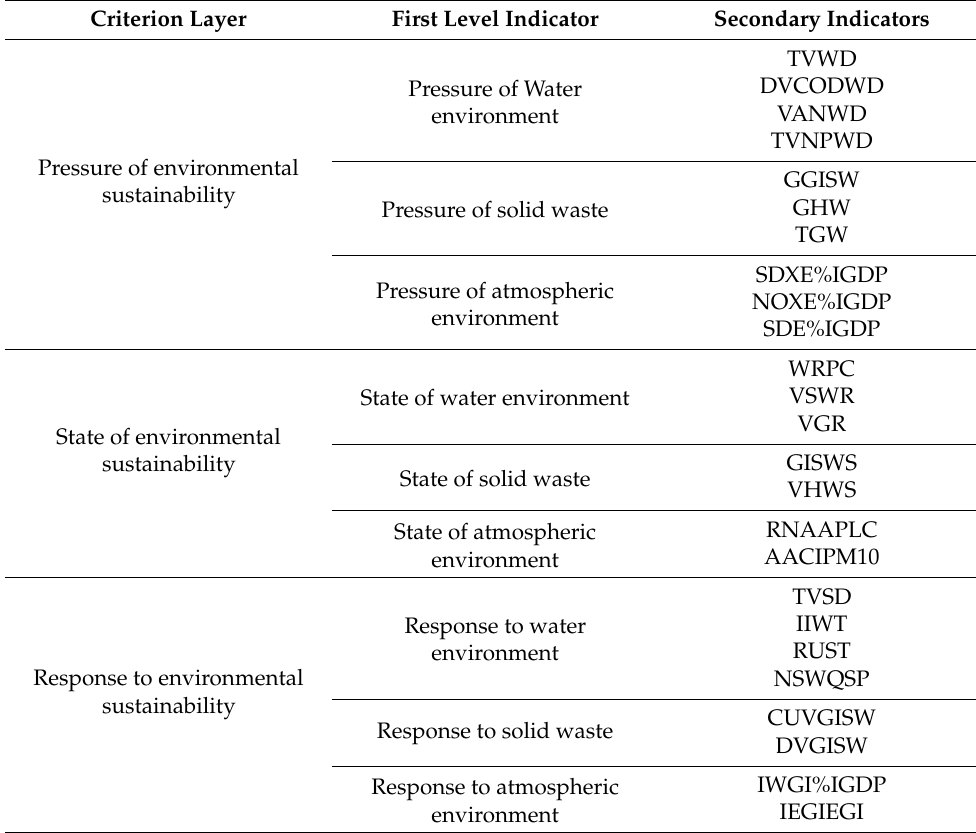
Table 6. Variables used in the